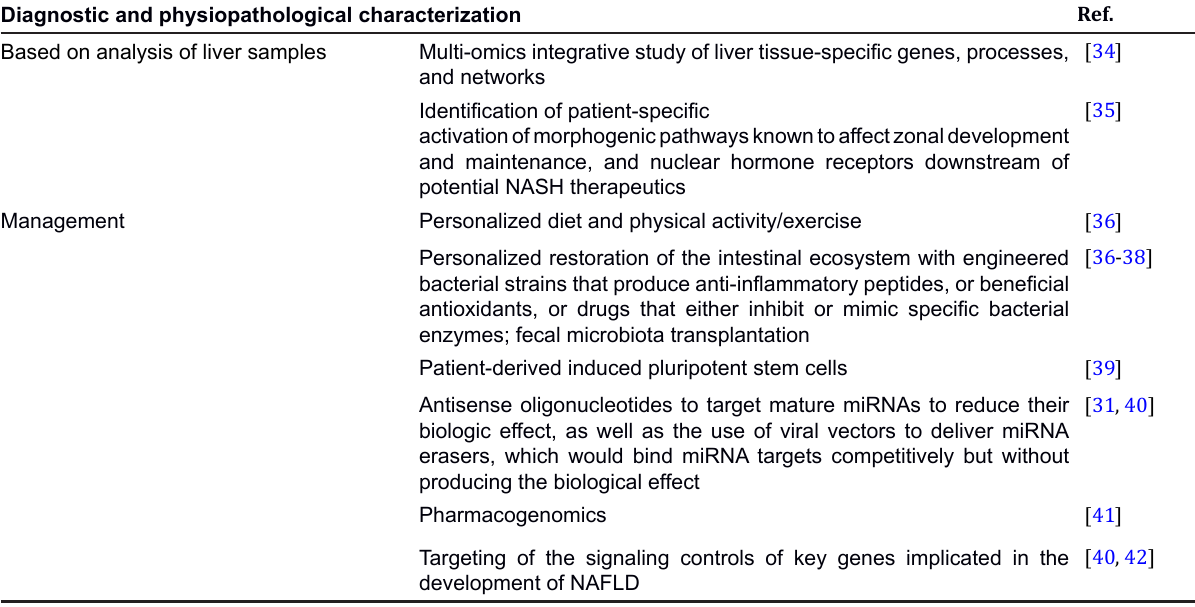
Table 2. Research agenda of selected topics on precision medicine approaches to NAFLD ( continued ) Diagnostic and physiopathological characterization